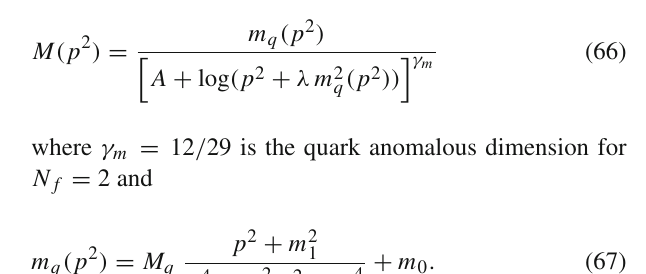
at high moment, we remove some of the lattice data at inter- mediate momenta. On Fig. 5 the data in the region with an orange background was not taken into account in the global fit of the running quark mass. The remaining lattice data was fitted to